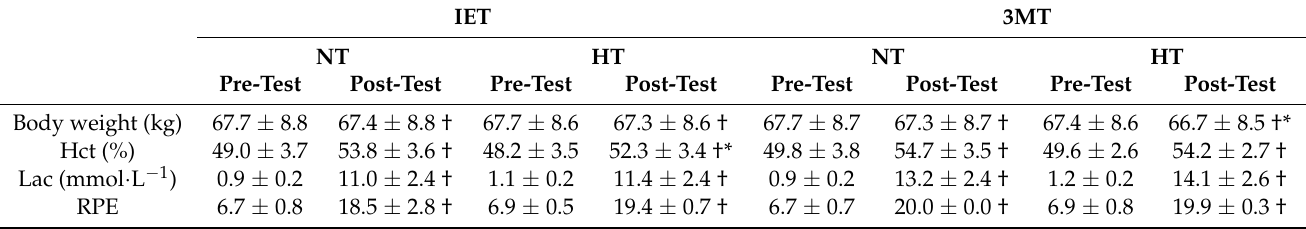
Table 3. Effect of different environmental temperatures on the physiological parameters related to exercise